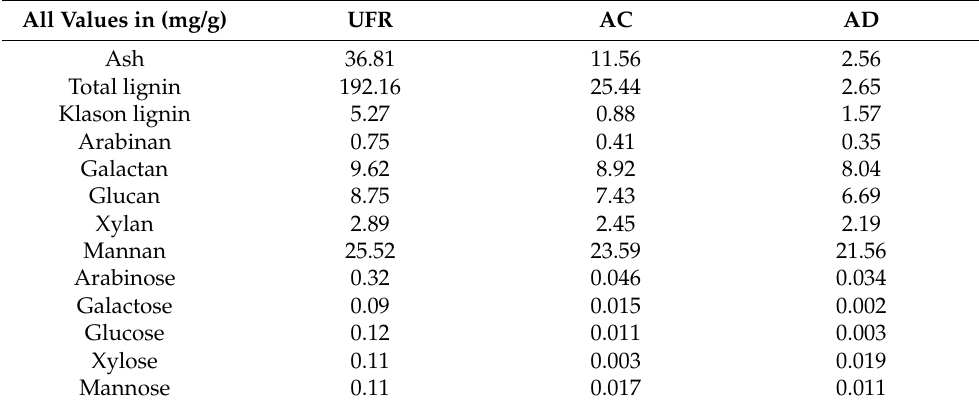
Table 1. Composition of SSL after different purification